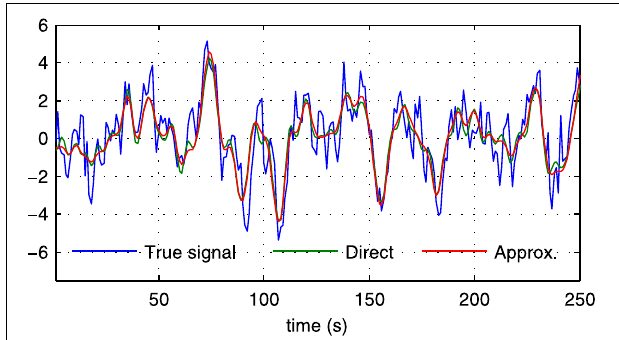
FIGURE 6 | Example of random hemodynamic response functions (HRFs) used in the experiment. The HRFs are generated from canonical HRFs where the parameters are drawn from a uniform distribution such that positions of the positive and the negative peaks lie in the intervals [ 2 . 5 s , 6 . 5 s ] and [ 15 s , 16 . 7 s ] , respectively. The bold dashed line shows the default HRF with peaks at 5 and